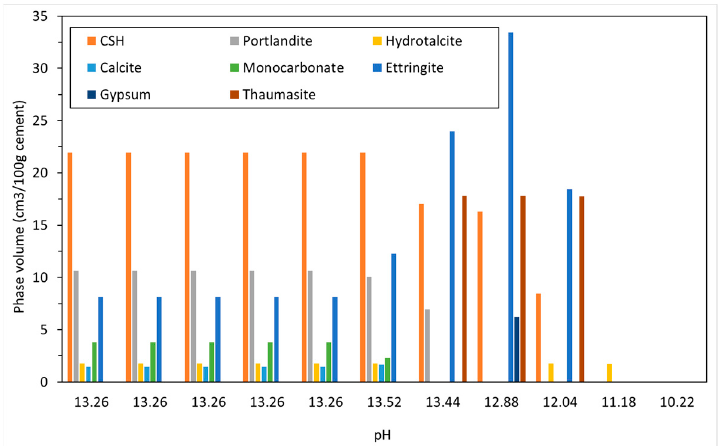
Figure 7. Change in solid phase volume with pH with increasing sodium sulfate ingress.